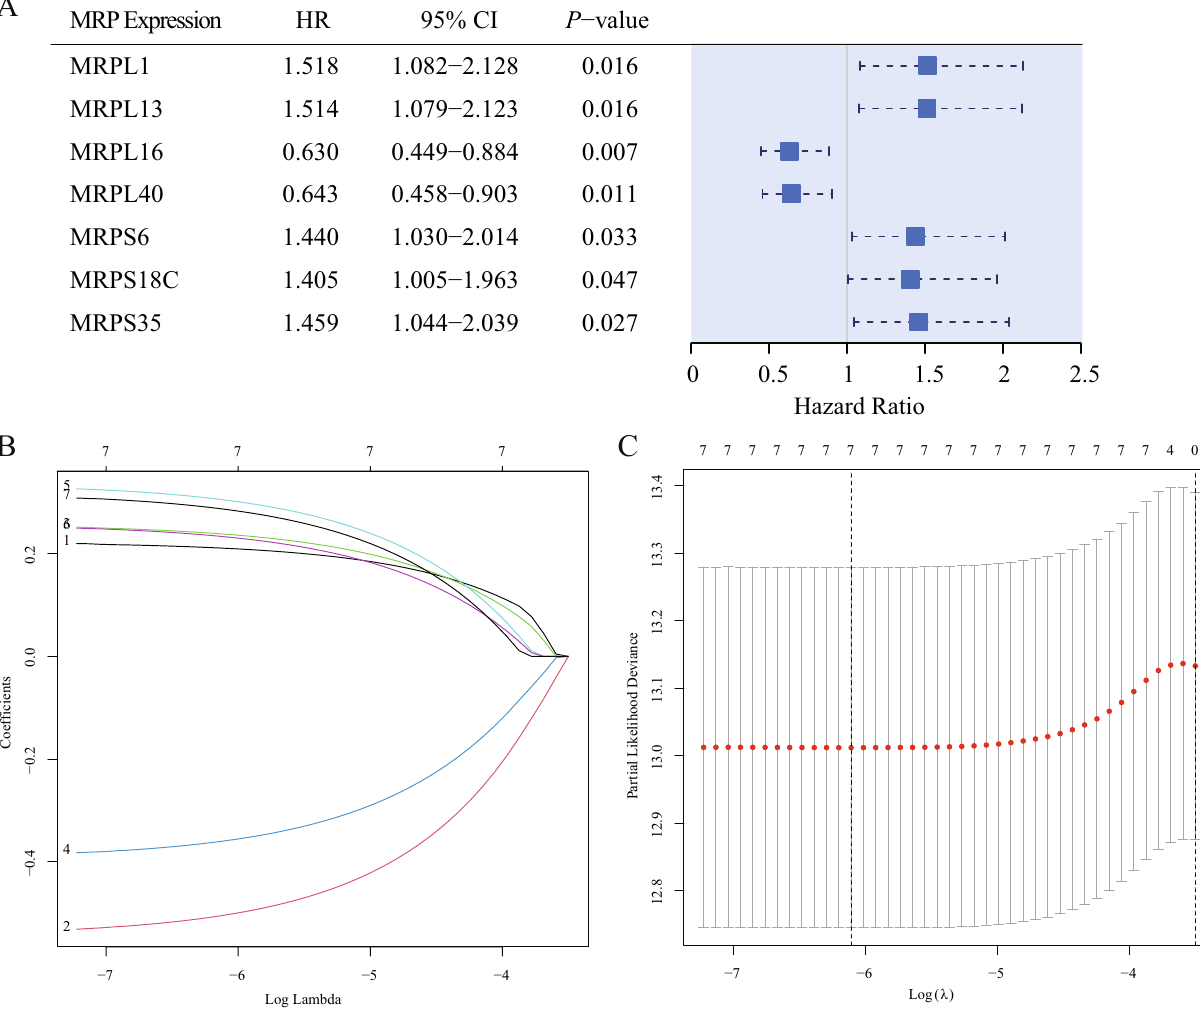
Figure 5. Construction of an MRP-based nomogram. ( A ) Forest plot of univariate Cox regression analysis of MRP genes. ( B ) Least absolute shrinkage and selection operator (LASSO) coefficient profiles of the 7 MRPs determined by the optimal lambda. ( C ) Selection result of the optimal lambda in the model. The partial likelihood deviance (binomial deviance) curve was drawn versus log(λ), and vertical dotted lines were made at the optimal